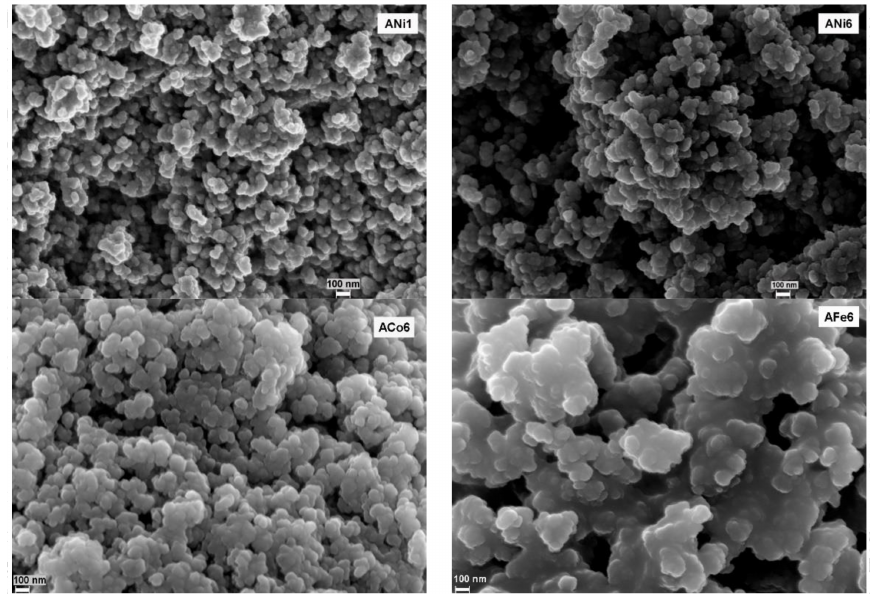
Figure 1. SEM microphotographs obtained at 100.00 KX of magnification of the samples ANi1, ANi6, ACo6 and AFe6.